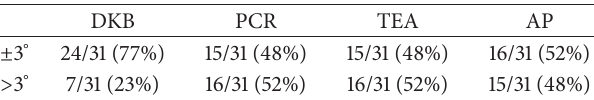
Figure 5: CT-scan on operative knee (after surgery). Measurement of femoral rotation in regard to anatomical epicondylar axis per- formed by two independent observers. Table 1: Anatomic alignment ( ± 3 ∘ ). Femoral component rotation relative to aTEA measured by CT using DKB method, PCR, TEA, and AP anatomic